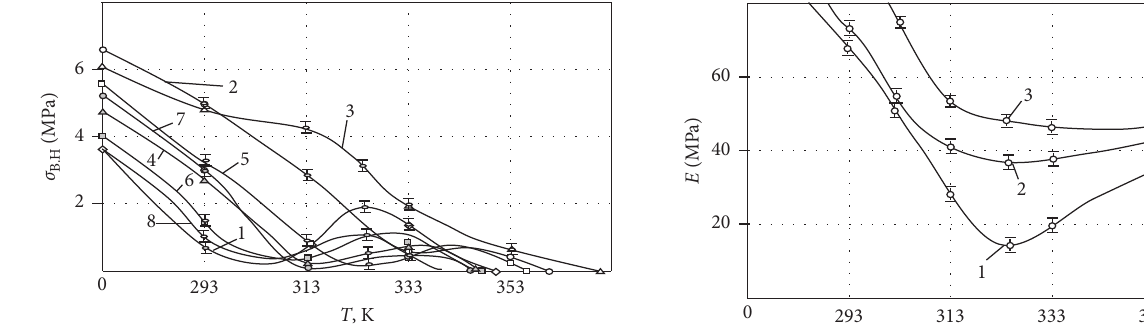
Figure 3: Dependence of internal stresses change on temperature for compositions on the basis of epoxy resin hardened by modes: 1: T � 293K, 72 hours; 2: T � 393K, 2 hours; 3: T � 293K, 72